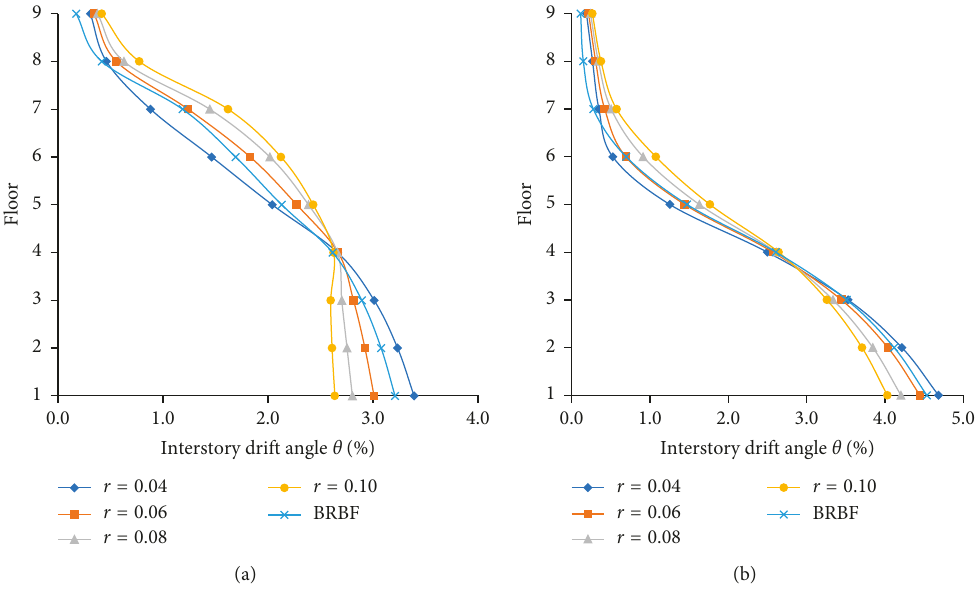
Figure 14: The effects of r on the interstory drifts of 9-story SC-TOBFs: (a) LD-1 and (b)